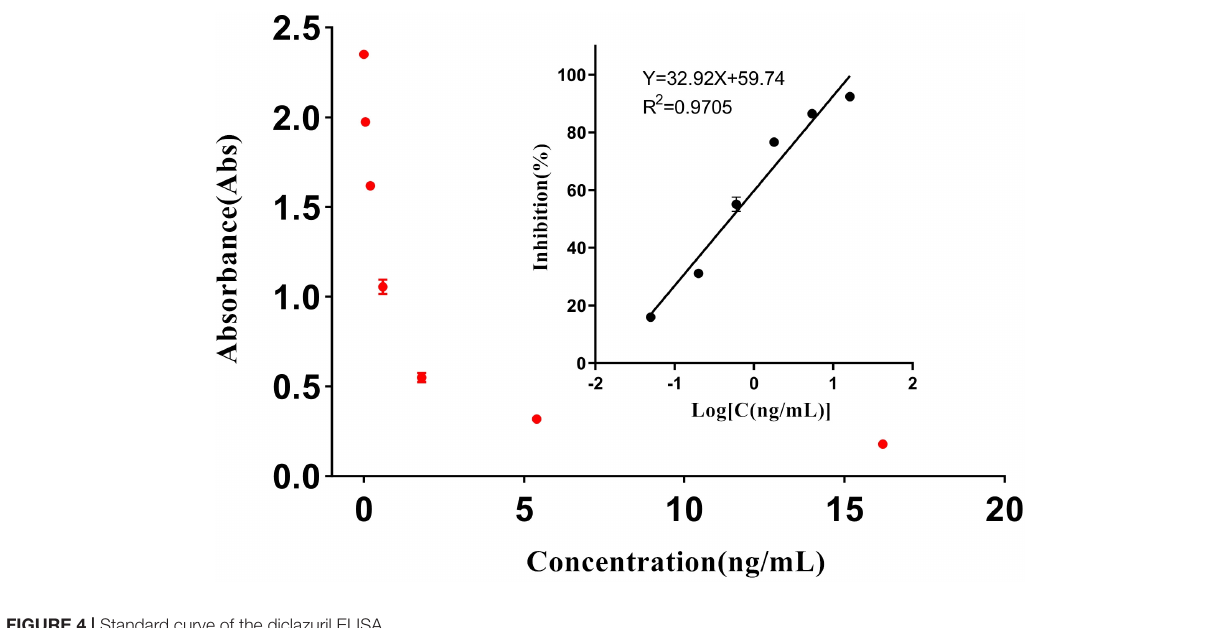
FIGURE 4 | Standard curve of the diclazuril ELISA. TABLE 3 | Determination of detection limits (unit: